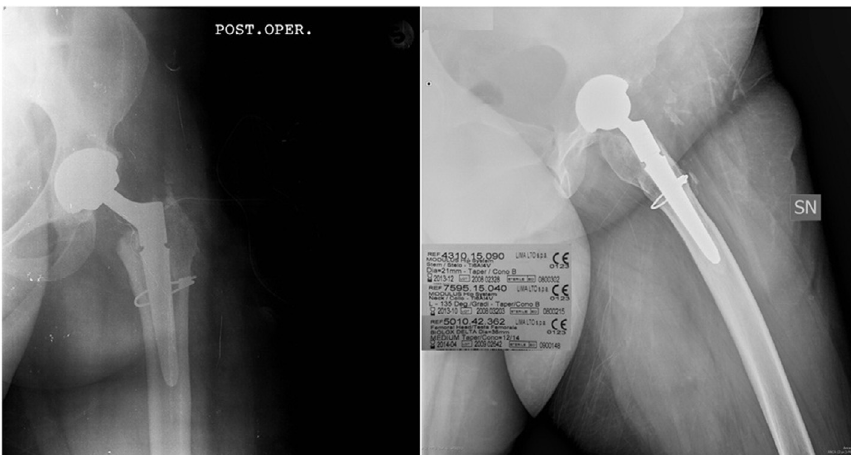
Figure 2. Postoperative X-ray after the Metha stem revision. The 1st implant revision was performed with Lima Modulus implant. Implant details: modulus stem 21 mm diameter, neck Ti6Al4V 135 (cid:2) taper B, Femoral Head 36 mm Biolox delta.